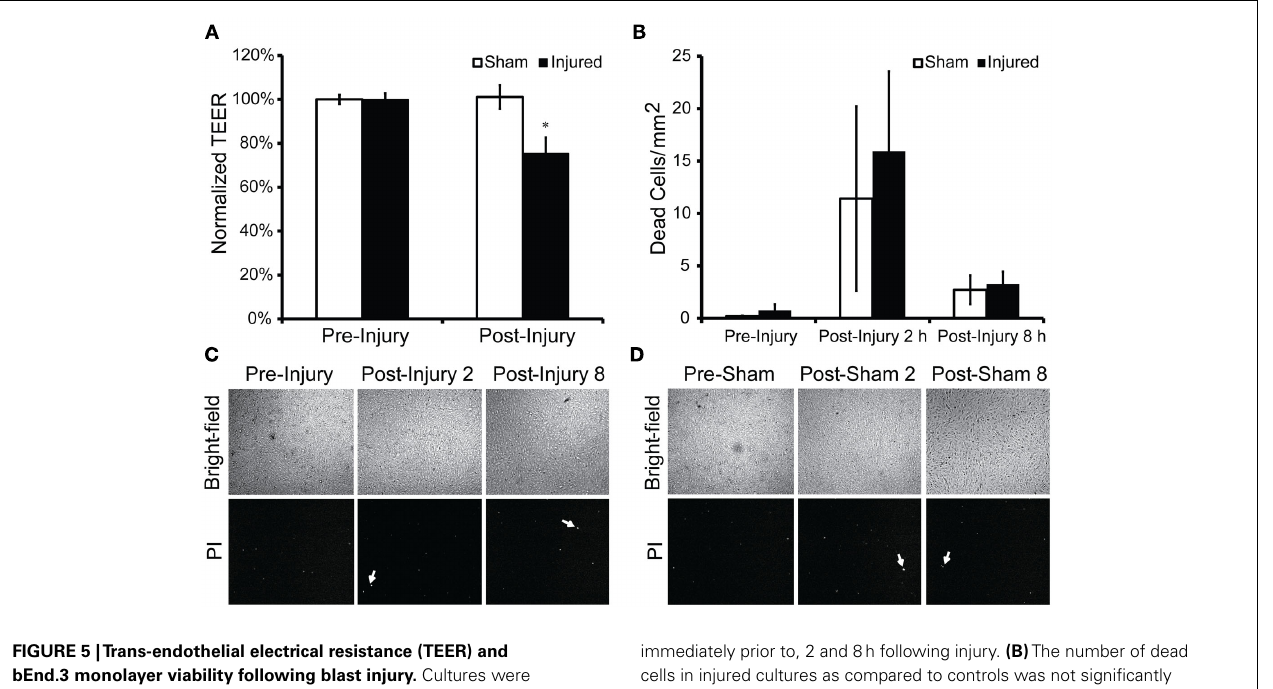
FIGURE 5 |Trans-endothelial electrical resistance (TEER) and bEnd.3 monolayer viability following blast injury. Cultures were exposed to 581 ± 10.0kPa peak overpressure with a 1.067 ± 0.006-ms duration and 222 ± 6.9kPa-ms impulse in-air. (A) An acute decrease in TEER was observed for the injured cultures immediately following injury to 75 ± 7% of pre-exposure levels (* p < 0.05; SEM; Sham n = 6; Injured n = 6). Bright-field and PI fluorescence images were taken